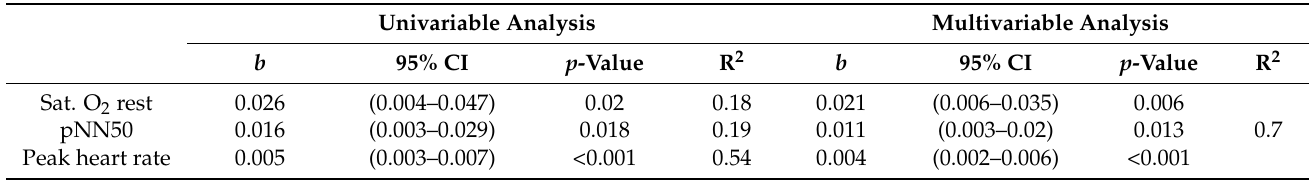
Table 7. Association between oxygen saturation at rest, pNN50, peak heart rate, and chronotropic index. Univariable Analysis Multivariable